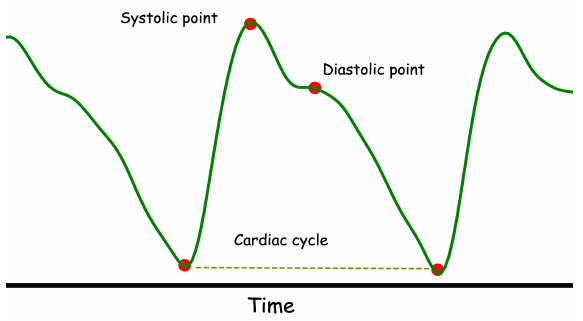
Figure 1. An example of a filtered PPG